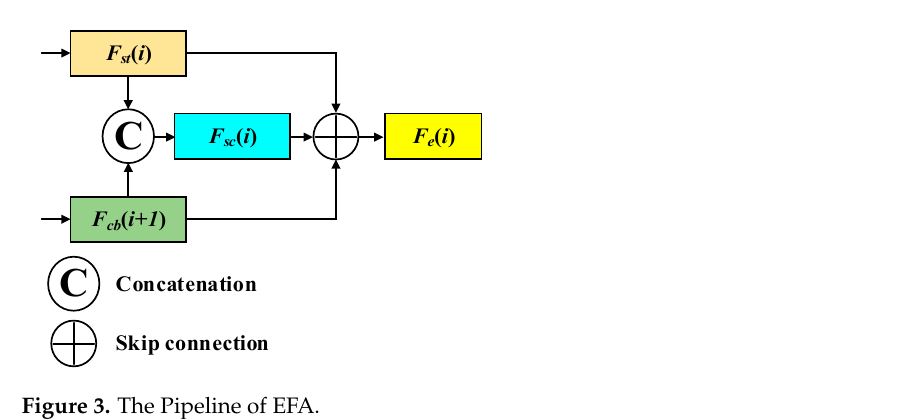
Figure 3. The Pipeline of EFA.